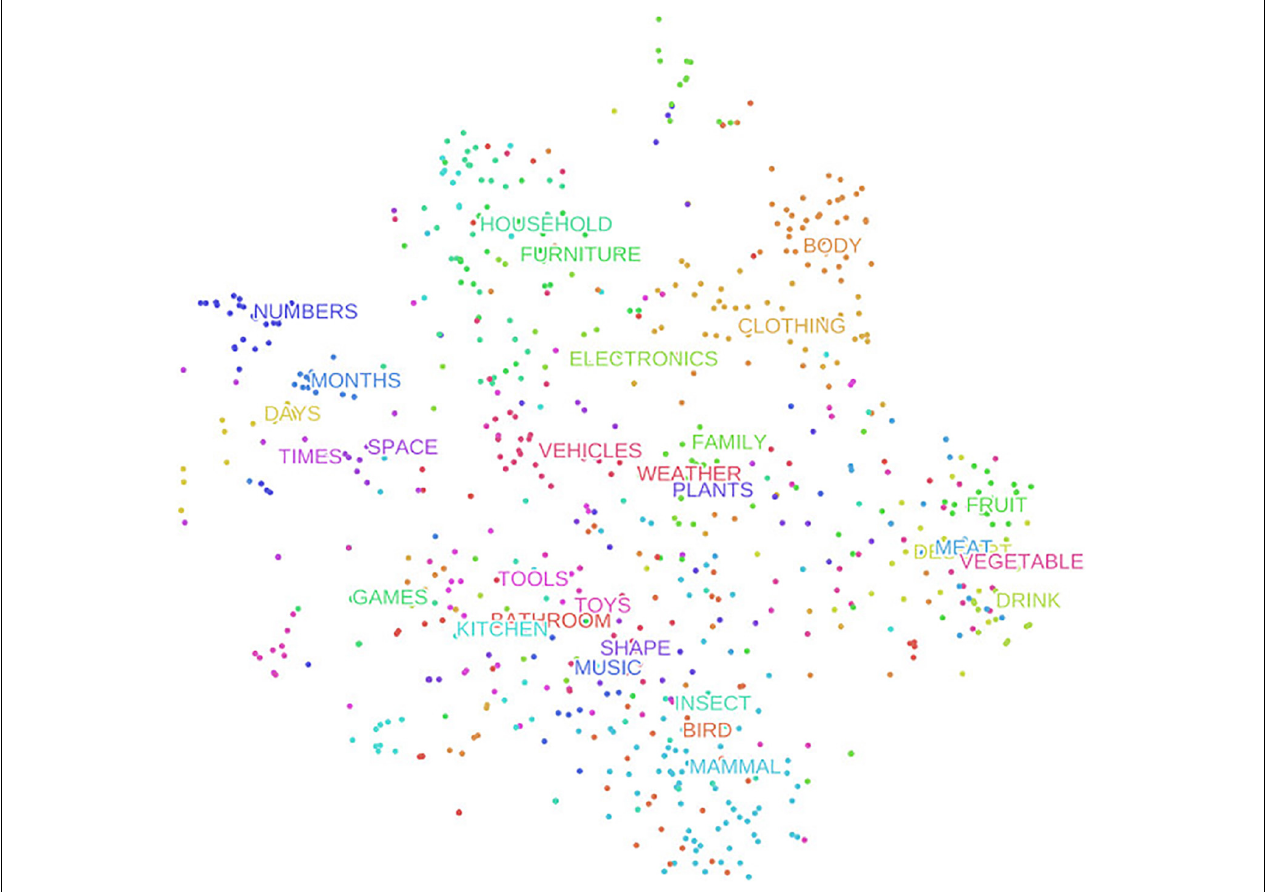
FIGURE 4 | A t-SNE dimensionality reduction projection, showing a 2-D representation of the relative similarities of the 720 probe-words learned by the SRN.